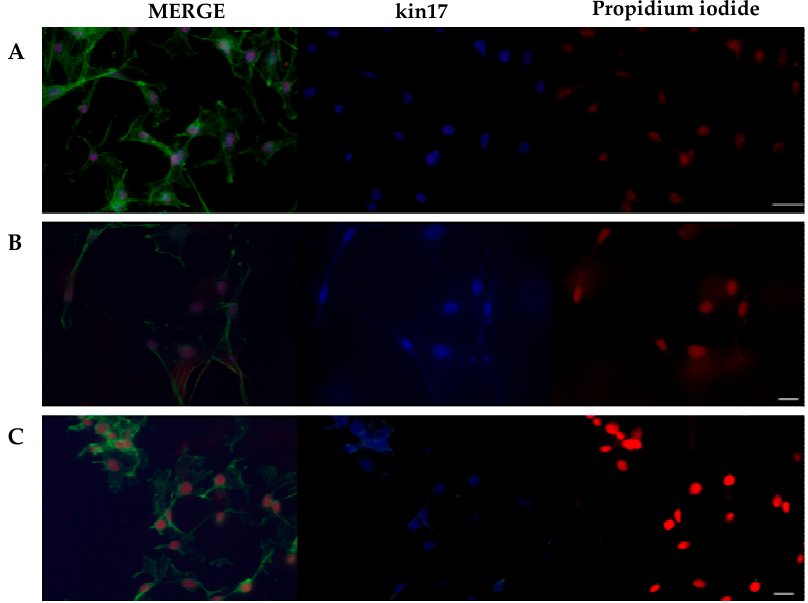
Figure 2. Immunodetection of the kin17 protein in murine melanoma tumor cells. B16F10-Nex2 cell line (antibody diluted 1:60), scale bar: 26µm ( A ); B16-8HR (1:40), scale bar: 16 µm ( B ) and B16-10CR (1:40), scale bar: 16 µm ( C ). Green, Alexa Fluor 488-conjugated Phalloidin; Red, propidium iodide; Blue, mouse anti-kin17 K58 clone followed by Alexa Fluor 350-conjugated goat anti-mouse.